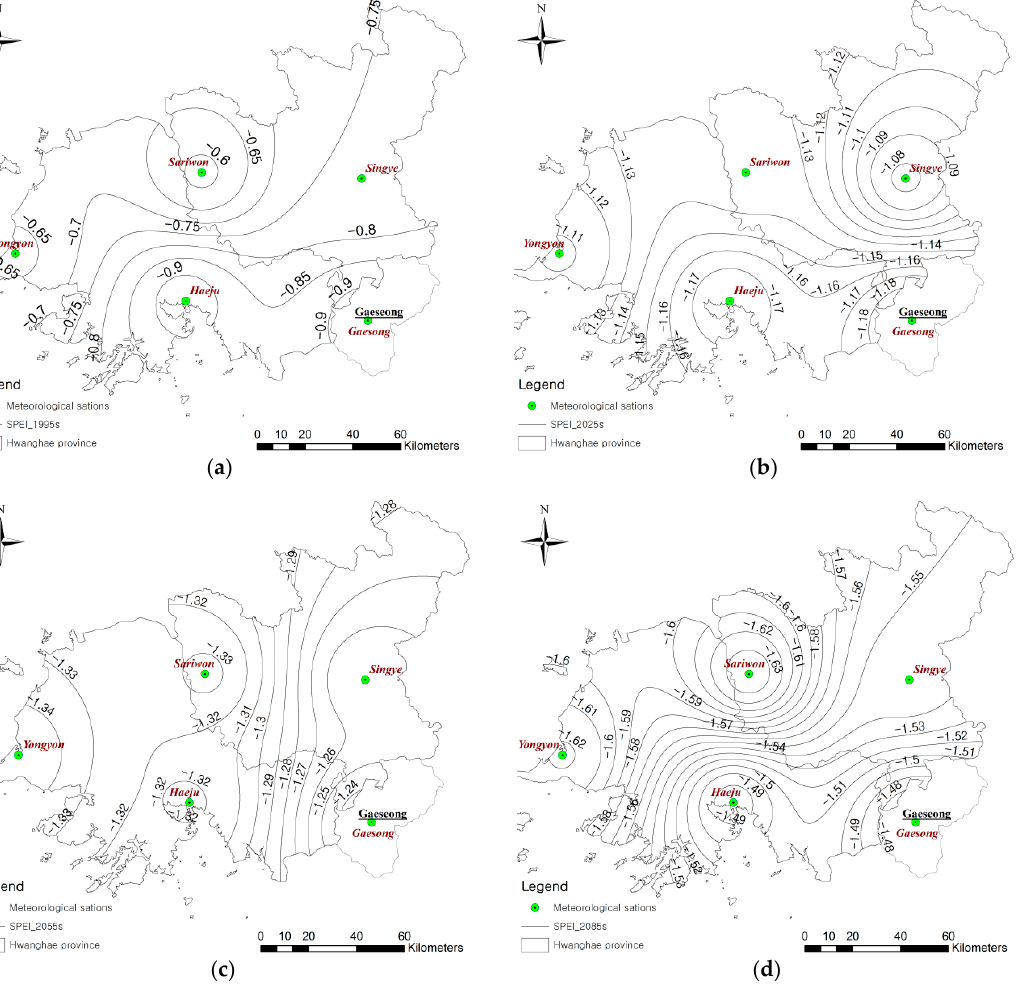
Figure 10. Contour lines of the one-month SPEI for a ten-year return period: ( a ) 1995s; ( b ) 2025s; ( c ) 2055s; ( d ) 2085s.